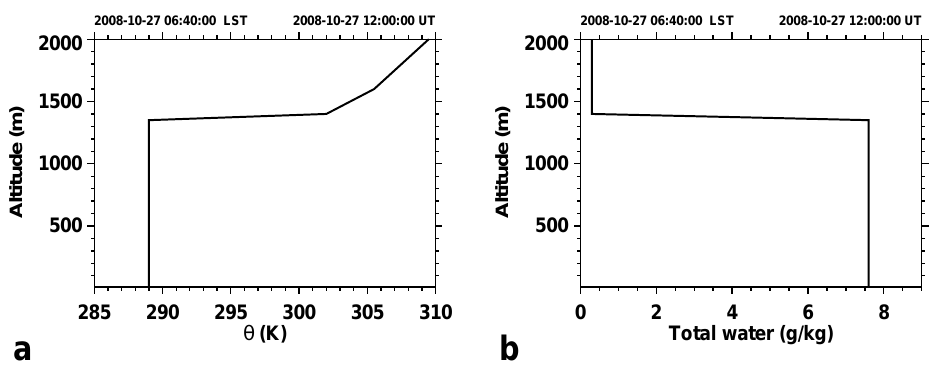
Fig. 1. Initial vertical profiles of (a) potential temperature and (b) total water mixing ratio, present as water vapor at the start of the